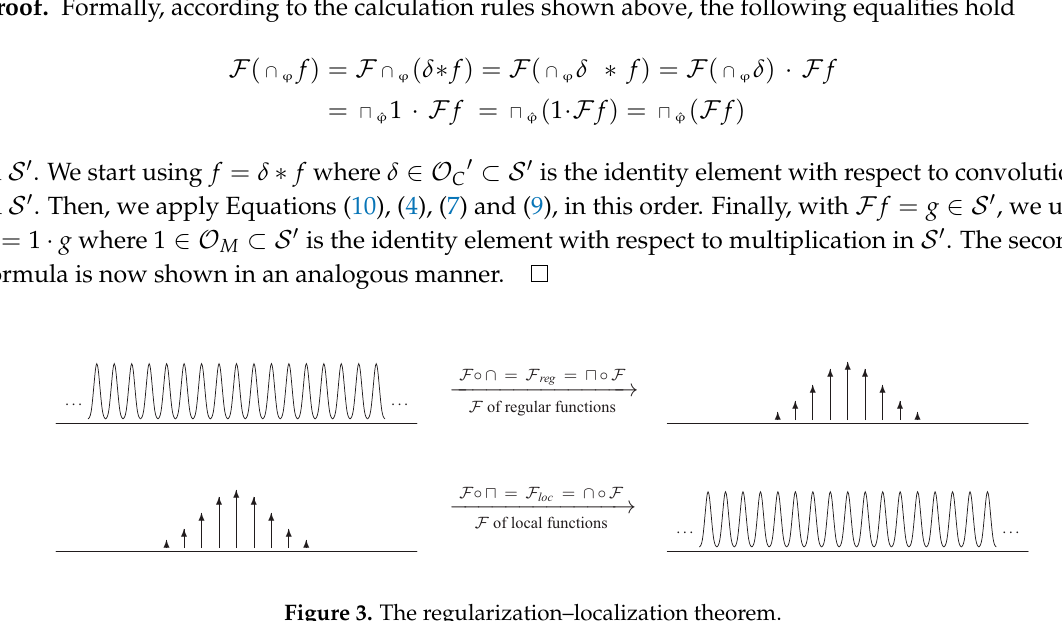
, , , ⊥⊥⊥ (cid:52)(cid:52)(cid:52) ∩ ϕ (cid:117) ˆ ϕ